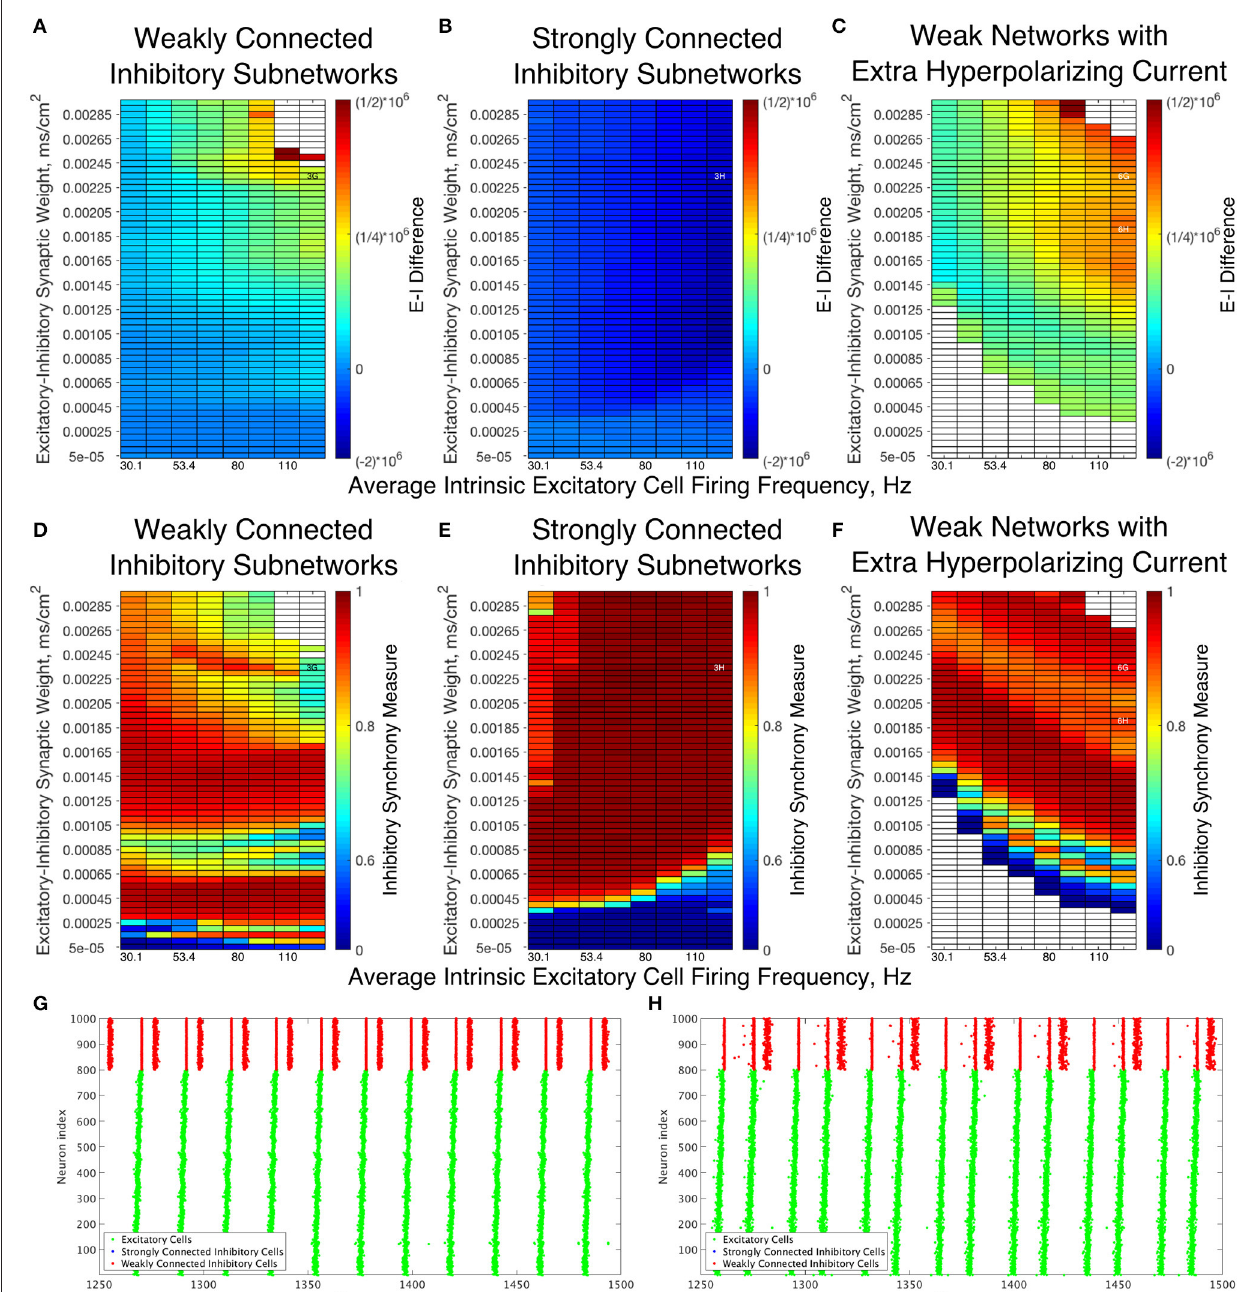
FIGURE 6 | Dynamical differences between networks with weakly connected and strongly connected inhibitory subnetworks are reflected in differences in E-I Difference and Inhibitory Synchrony Measure, even with changes to the external hyperpolarizing current. (A–C) Synaptic E-I Difference for Weak Networks (A) , Strong Networks (B) , and Weak Networks where the external hyperpolarizing current is increased from 0.2 to 3.0 µ A/cm 2 (C) . (D–F) Inhibitory Synchrony Measure for the − − same three network types. White entries in the heatmaps indicate that the measure could not be calculated due to insufficient inhibitory activity, and overlaid alphanumeric codes indicate position of example raster plots seen in Figure 3 (for comparison to those shown here) and in this figure. (G,H) Example raster plots for Weak Networks with Extra Hyperpolarizing Current; both examples are for a network with an average intrinsic excitatory cell firing frequency of 126 Hz, with (G) an example from a network with an E-I synaptic weight of 0.00235 mS/cm 2 while (H) is an example from a network with an E-I synaptic weight of 0.00190 mS/cm 2 . Weak Networks, both with and without additional hyperpolarizing current, show a dominance of excitatory synaptic activity reflected in positive E-I Difference values that increase as the E-I synaptic weight increases, while Strong Networks show a dominance of the inhibitory synaptic activity reflected in largely uniform negative values of the E-I Difference. Moreover, Weak Networks with Extra Hyperpolarizing Current retain distinct behaviors from Strong Networks as illustrated by the Inhibitory Synchrony Measure and example raster